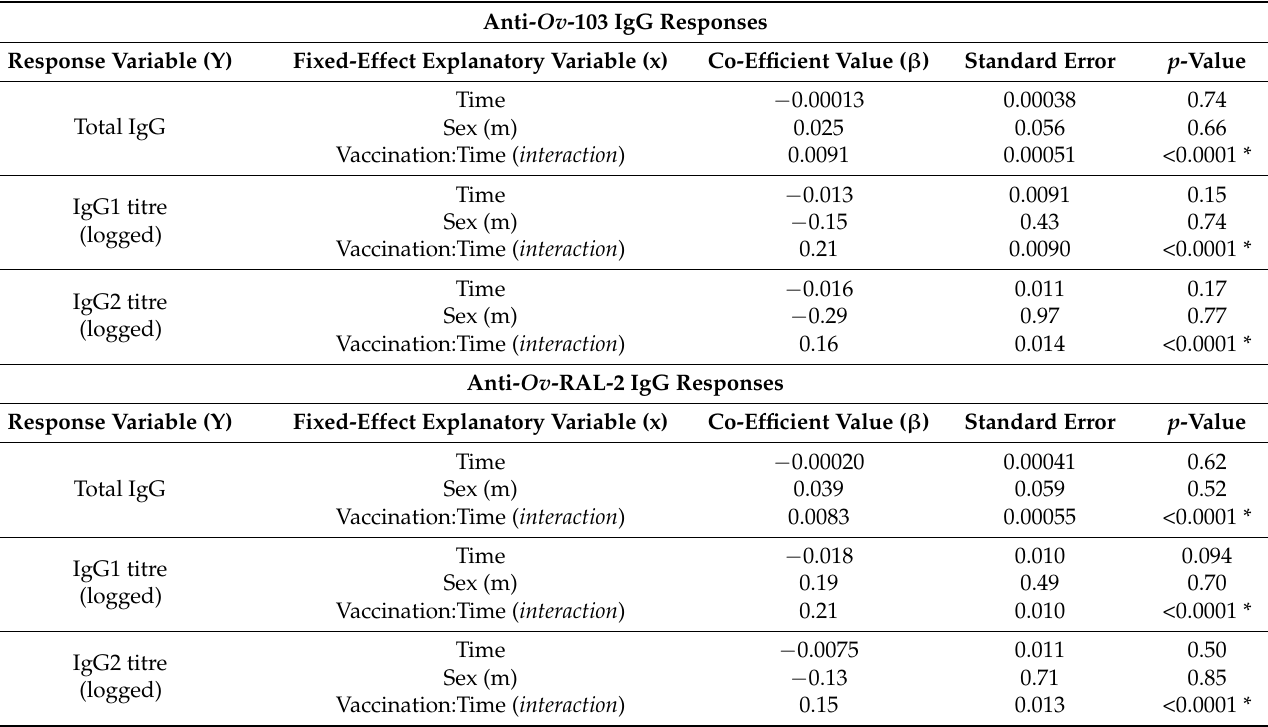
Table 4. Multivariable linear mixed effects regression analysis results for antigen-specific antibody responses in vaccine efficacy trial calves over immunisation period